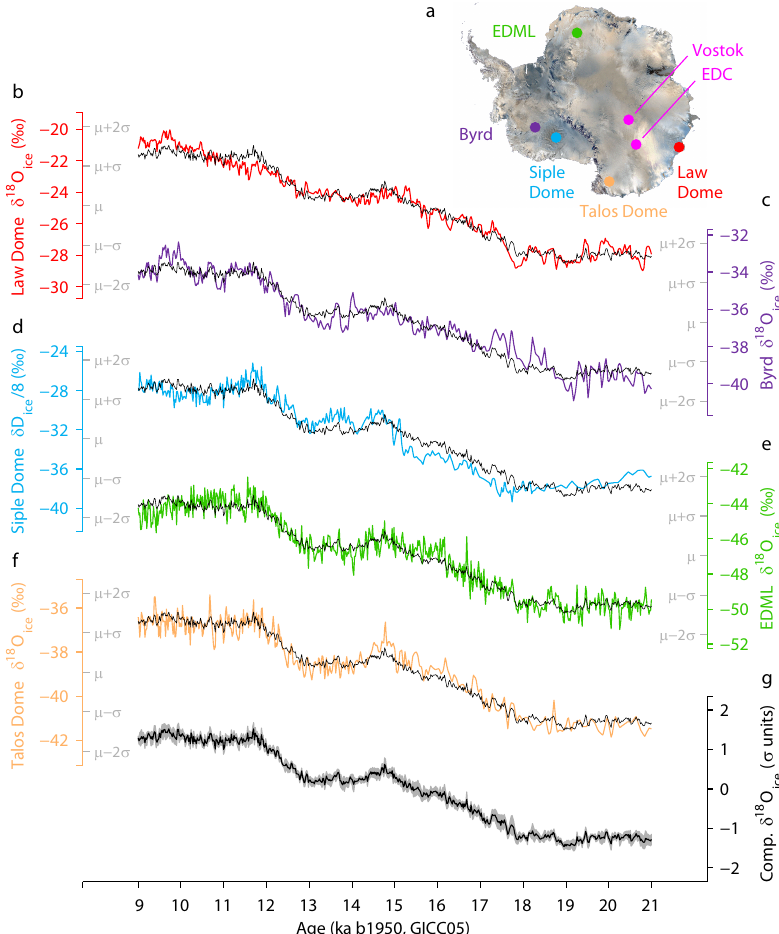
Fig. 1. δ 18 O ice records from high-accumulation/near-coastal sites used to construct the Antarctic composite. (a) Map showing the location of the ice cores used and other records mentioned in the text (source: NASA). (b) – (f) Deglacial δ 18 O ice records from LD, Byrd, Siple Dome, Talos Dome, and EDML all placed on the common GICC05 timescale; the individual vertical axes are scaled according to the standard deviation of each record, as can be seen from the inner σ axis labels (in grey). (g) The Antarctic composite δ 18 O ice (black, also overlain in panels (b) – (e) ) is shown bracketed by the standard error in the mean of the δ 18 O ice records from the five sites (grey shading). Estimated dating uncertainty in the composite (relative to GICC05) is 380yr, 200yr, and 220yr for intervals 15 to 18kaBP, 13 to 15kaBP, and 10 to 13kaBP, respectively. Note that for Siple Dome the actual δ 18 O ice values were not available, so we use an appropriately scaled version of δ D ice (see Appendix